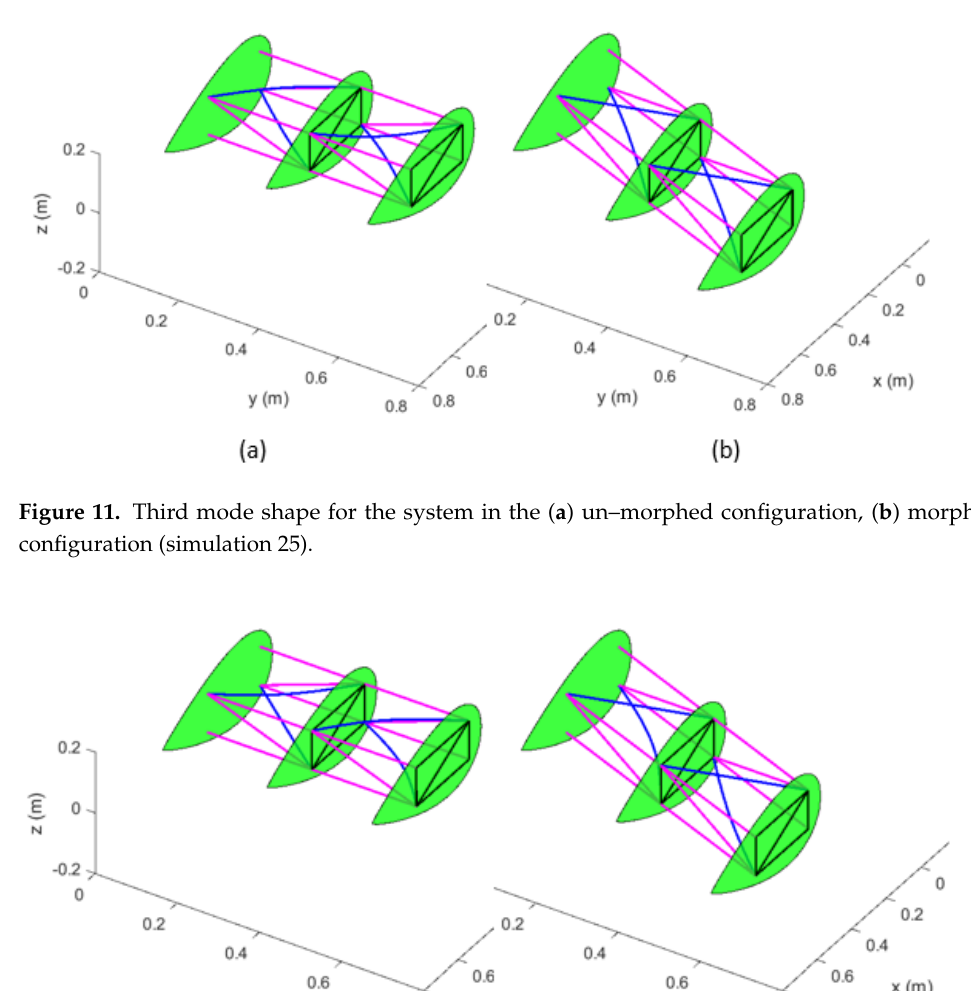
Figure 10. Second mode shape for the system in the ( a ) un–morphed configuration, ( b ) morphed configuration (simulation 25).